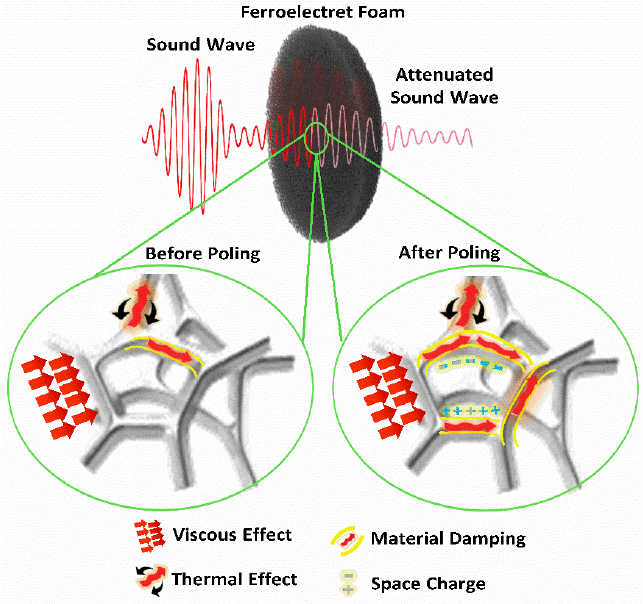
Figure 4. A schematic illustration of the mechanical energy dissipation mechanisms in ferroelectret foam with the presence of space charges and additional material damping after corona poling in comparison with before the poling.